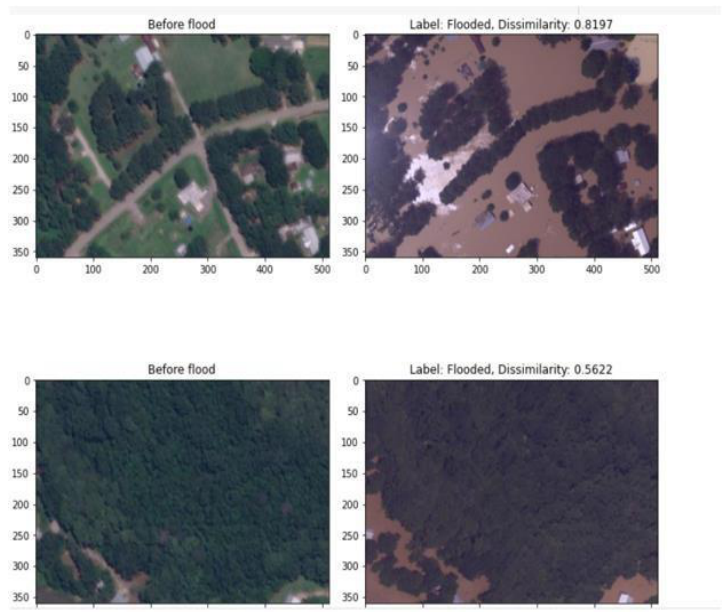
Fig. 5. Disaster detection using Satellite